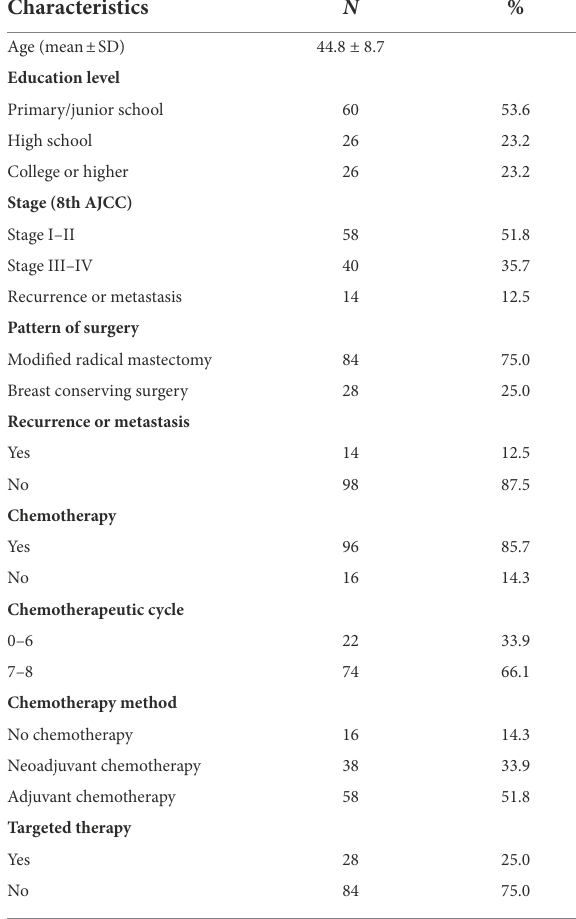
TABLE 1 The demographic and clinical characteristics of patients ( N =